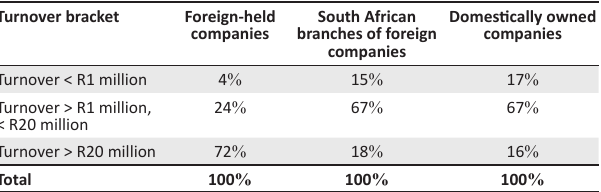
TABLE 5: Composition of companies in the 75th percentile and upwards by size. Turnover